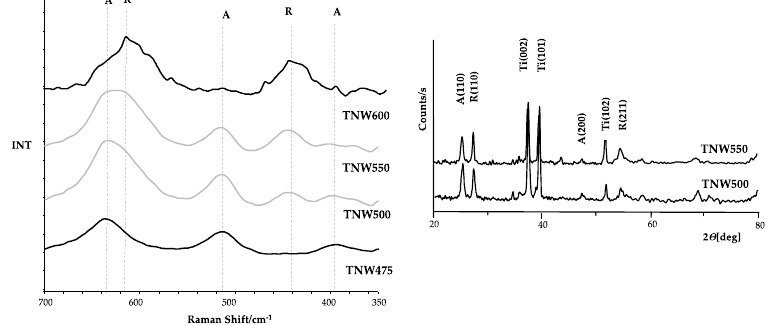
Figure 6. Raman spectra of TNWs ( a ) and (grazing-angle X-ray diffraction) GAXRD spectra of TNW500 and TNW550 ( b ).